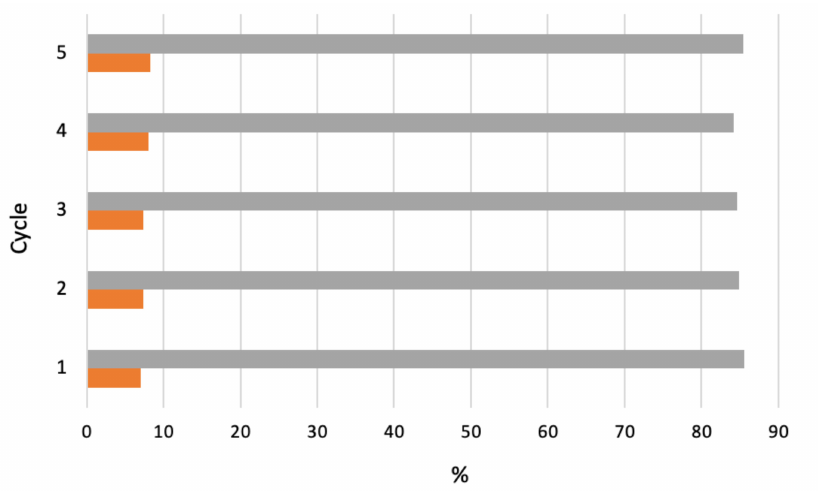
Figure 17. Effect of four cycles of recalcination–reuse of 20%CoMo/FDU-12 catalyst on cyclohexane conversion ( (cid:4) ) and selectivity ( (cid:4) ) to cyclohexanol and cyclohexanone [157].